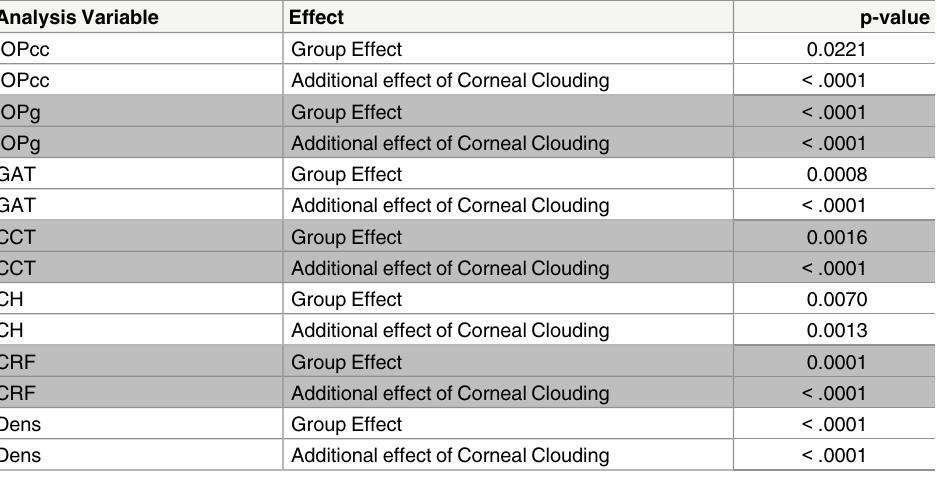
Table 4. Effects of diagnostic group and corneal clouding: p-values.